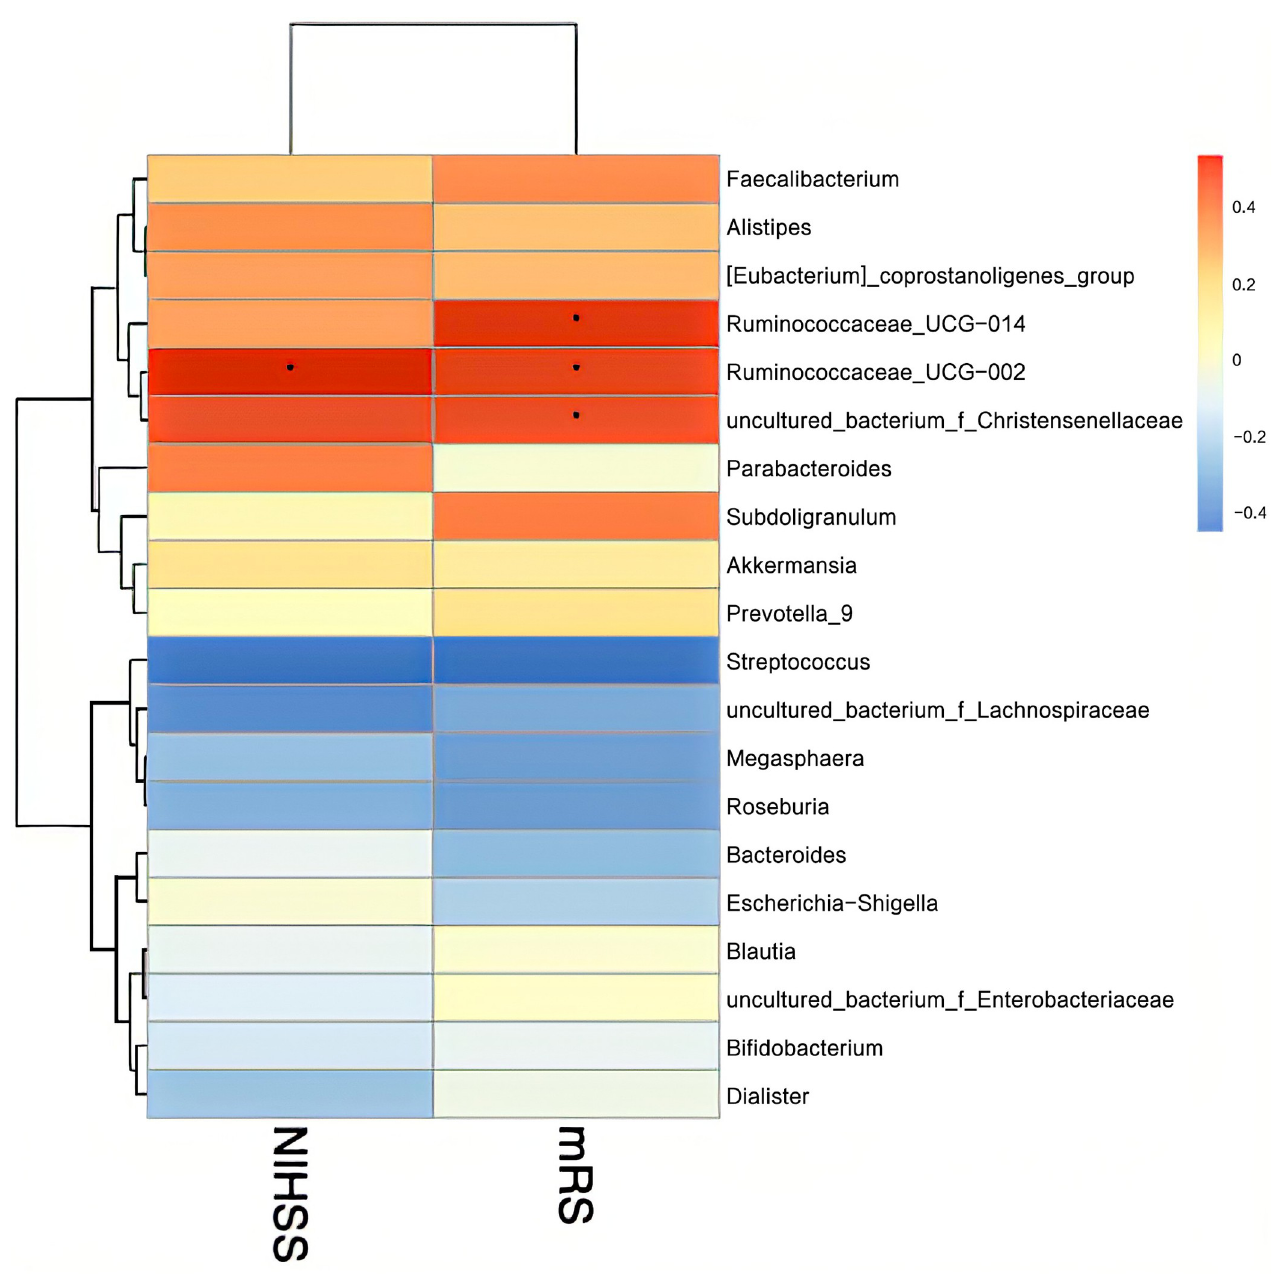
Fig 12. Heatmap of the Spearman correlation coefficients between the gut microbiota at the genus level and severity of stroke measured by NIHSS and mRS scores at admission. � P < 0.05, �� P < 0.01. NIHSS: National Institutes of Health Stroke Scale, mRS: modified Rankin Scale.